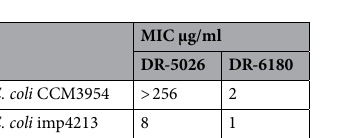
Figure 9. Effect of LPS on LPPO-induced leakage from liposomes. Carboxyfluorescein-loaded liposomes composed of dioleyl-phosphatidylglycerol (solid line) and diolelyl-phosphatidylethanolamine (dashed line) in ratios of 2:1 and 1:2 (w/w), respectively, which is the same as in Fig. 7A,B,D,E. Liposomes were preincubated with LPS (for details, see “Materials and methods”) and then exposed to LPPO I DR-5026 ( A , B ) and LPPO II DR-6180 ( C , D ) at the indicated concentrations. The resulting leakage curves (diamonds) are compared with those using liposomes without LPS treatment. The phospholipid concentration in liposome suspension was 10 µM. Representative kinetics from three independent liposome preparations are shown.